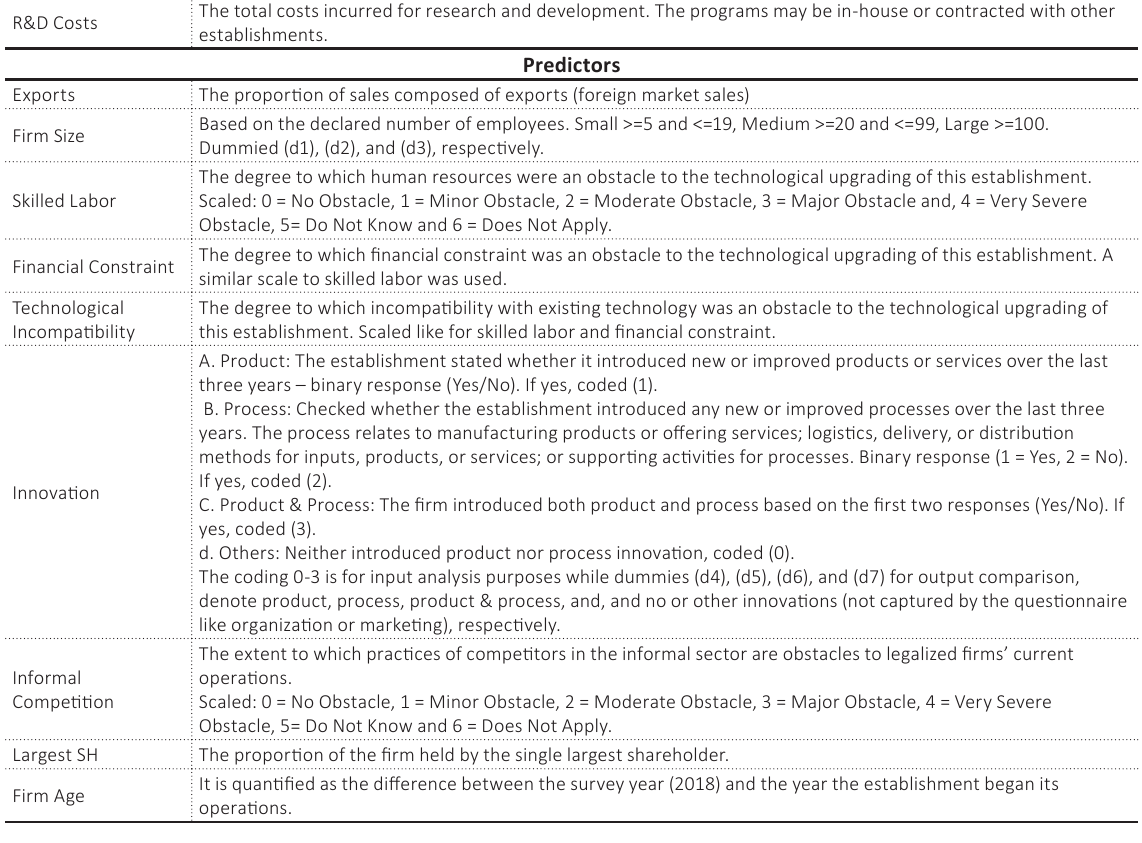
Table 1. Description and measurement of variables